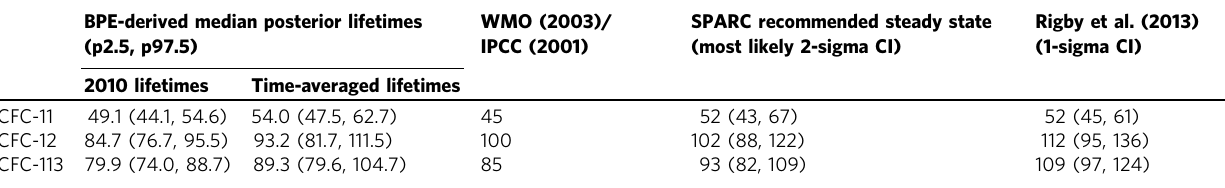
Table 1 Posterior atmospheric lifetime estimates for the unexpected emissions scenario and a comparison with previously published